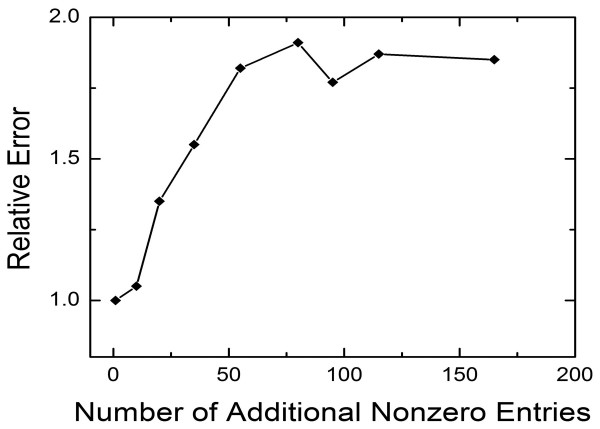
The sum of the square mismatch between the predicted and actual TF time course relative to the one obtained using the actual gene control network shown in Table 1. Although the mismatch increases as the number of interactions in the gene control network increases, it stays within a limit of 2 in this particular example, showing the potential of our approach to discover the operating gene control network hidden in a larger one (see Table 1 and 2 provided in the supplementary material).